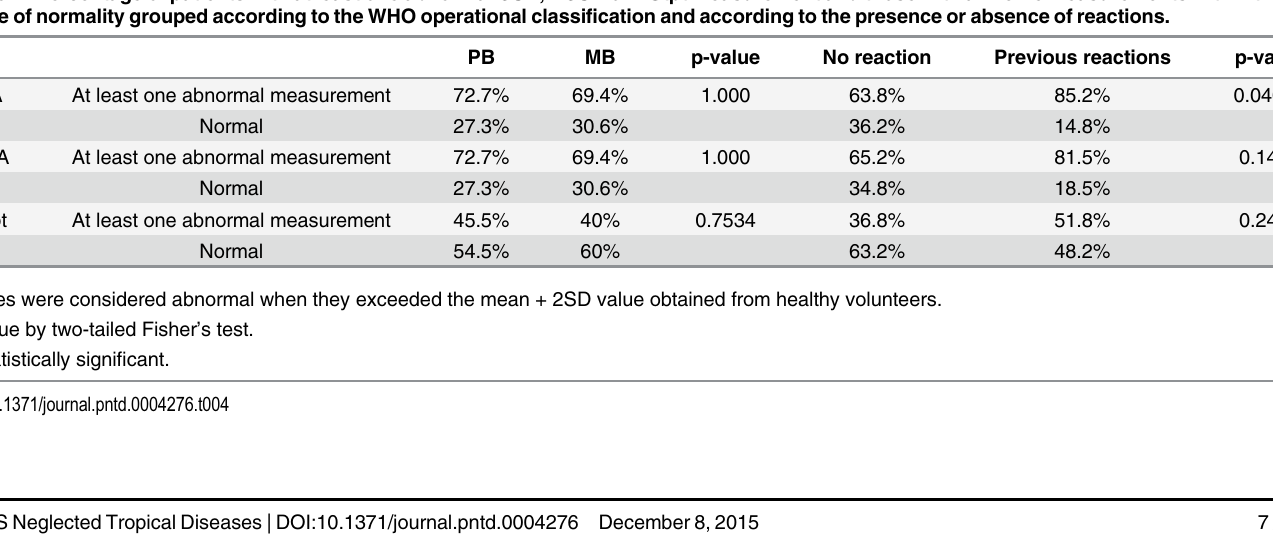
Table 4. Percentage of patients with at least one abnormal CSA, Δ CSA or Δ Utpt measurement and those with all nerve measurements within the range of normality grouped according to the WHO operational classification and according to the presence or absence of reactions. PB MB No reaction CSA At least one abnormal measurement Normal Δ CSA At least one abnormal measurement Δ Utpt At least one abnormal measurement